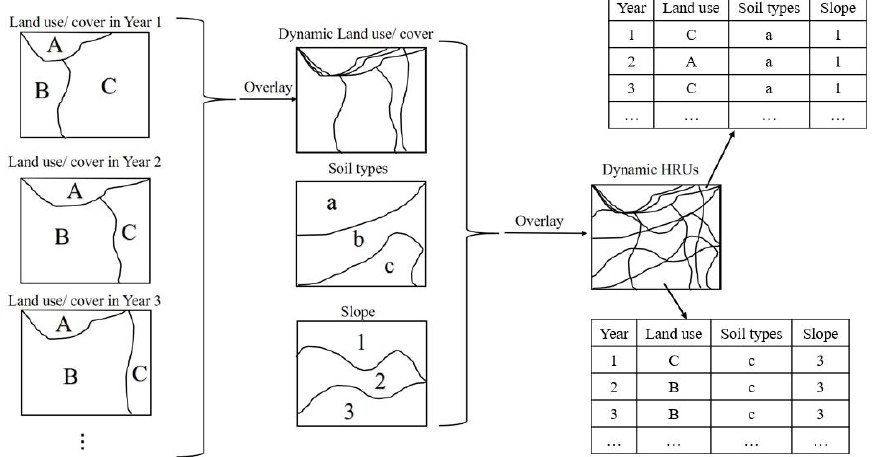
Figure 3. Production of dynamic hydrological response units (HRUs).